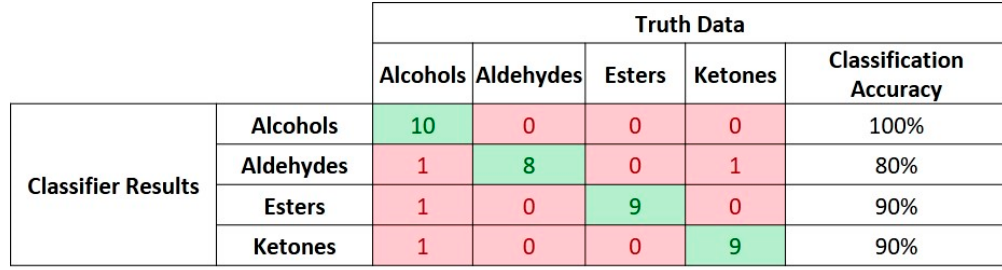
10 of 14 Figure 8. SNN-classifier performance for the 20-class dataset . For the second scenario involving classification of the dataset based on chemical groups of each compound, the discretization levels of the AERO encoder had to be reconfigured and reduced to 5- bit representation in order to allow the SNN to identify discriminative features and generalize the input data. Although the discretization of the input space was reduced, the number of neurons per class had to be increased as the number of events for learning and processing for each class also